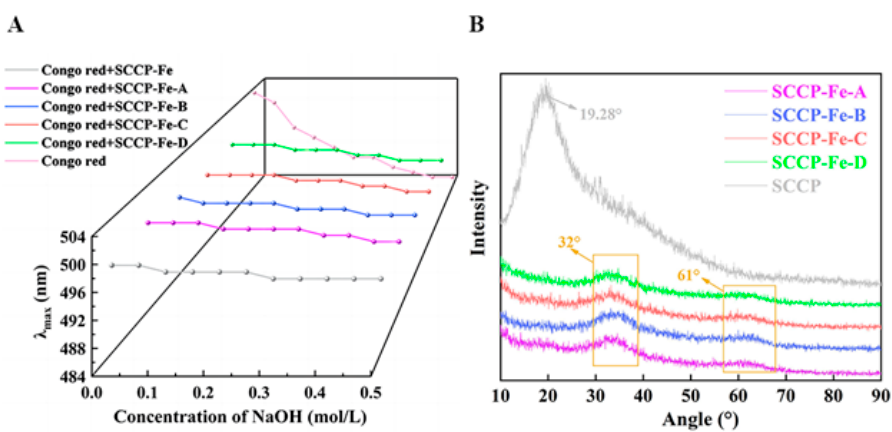
Figure 4. Congo red test ( A ) and XRD analysis ( B ) of four sweet corn cob polysaccharide-iron (III) complexes.